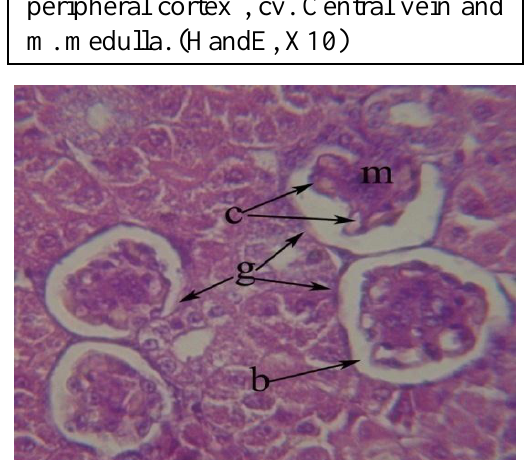
Fig. 8: photomicroscope illustrate iv. interlobular vein contain e. erythrocyte and neighbor to h. Henle's loop (HandE, X40)